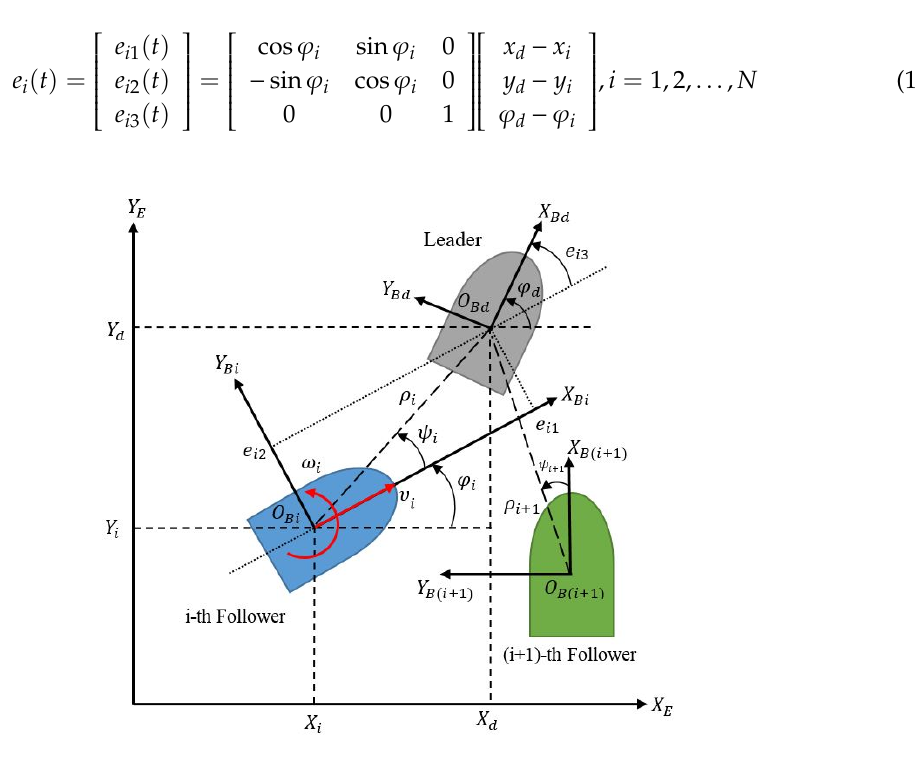
Figure 4. Leader-follower formation model.